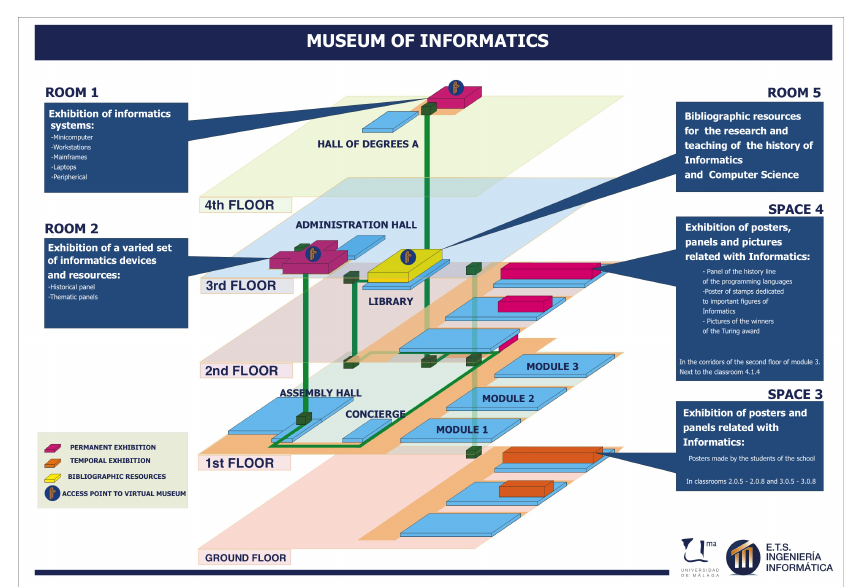
Figure 1. Plan of the Museum of Informatics (available at